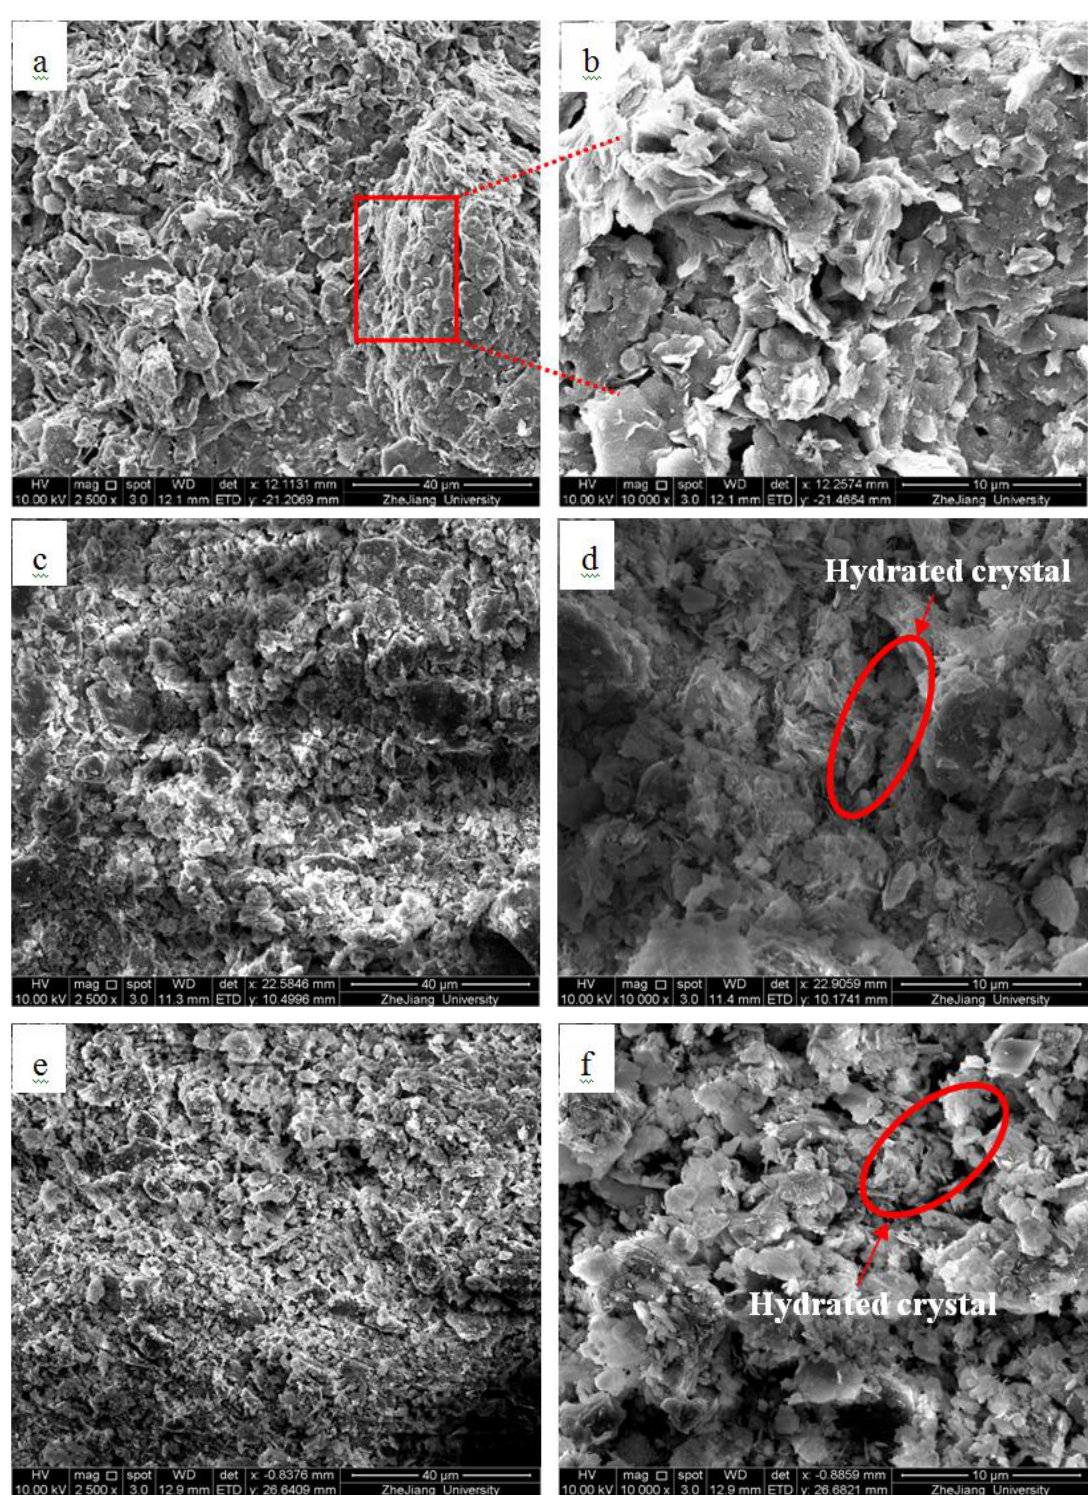
Figure 10. SEM micrographs of solidified sediment with di ff erent magnification, ( a , b ) natural sediment; ( c , d ) natural sediment mixed with 8% curing agent; ( e , f ) natural sediment mixed 3% organics and 8% curing agent.